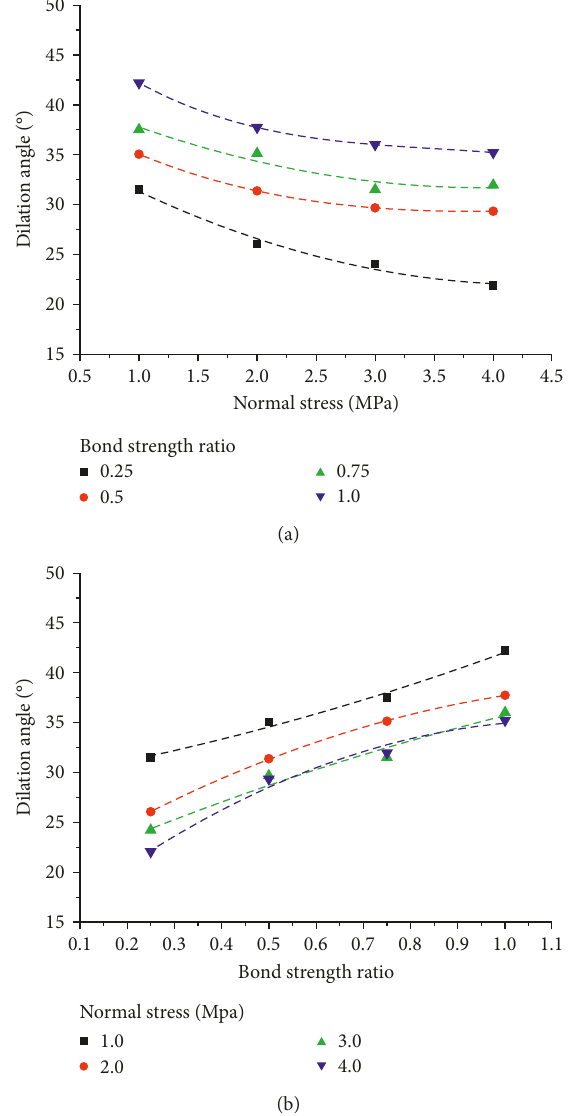
Figure 7: Trends of the peak dilation angle: (a) relationship of dilation angle and normal stress; (b) relationship of dilation angle and bond strength ratio.